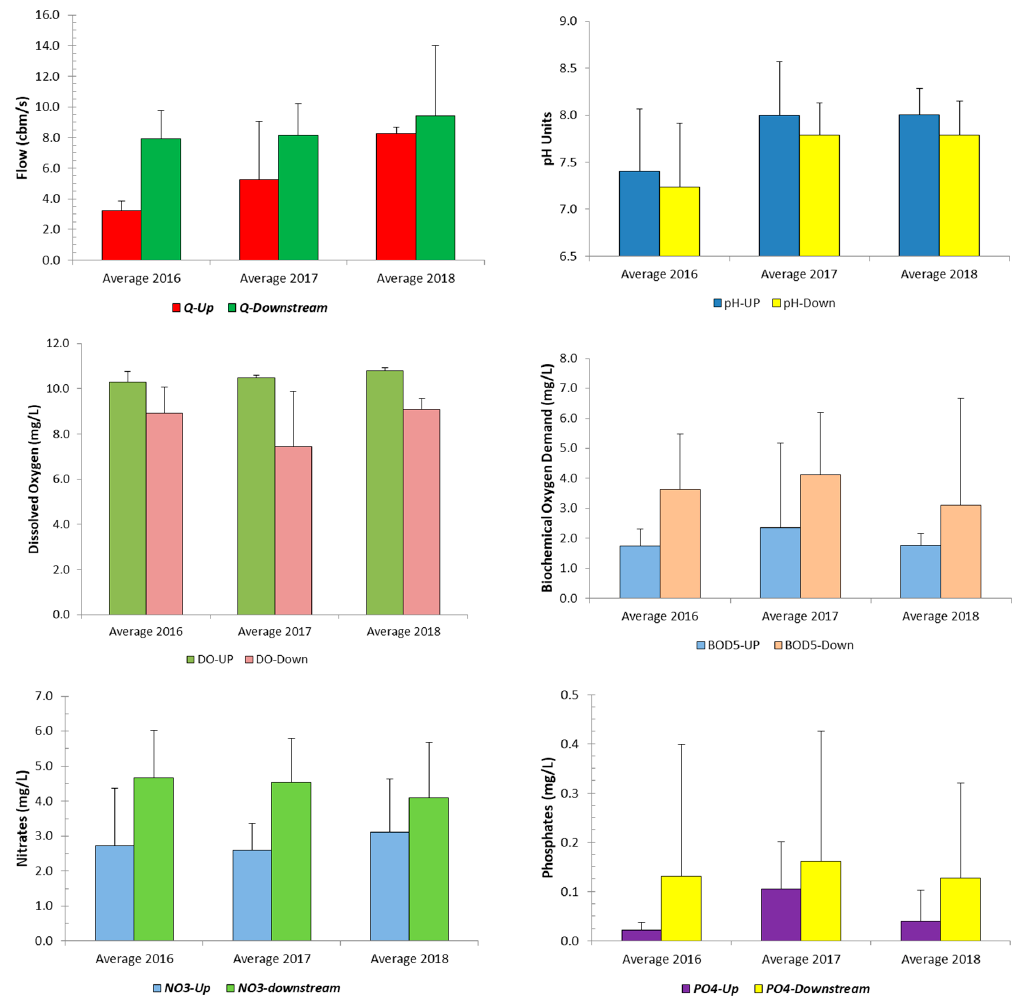
Figure 7. River flow, pH and water quality parameters in the upper part of the Ialomita River Basin upstream and downstream of Targoviste city; error bars represent standard deviation.